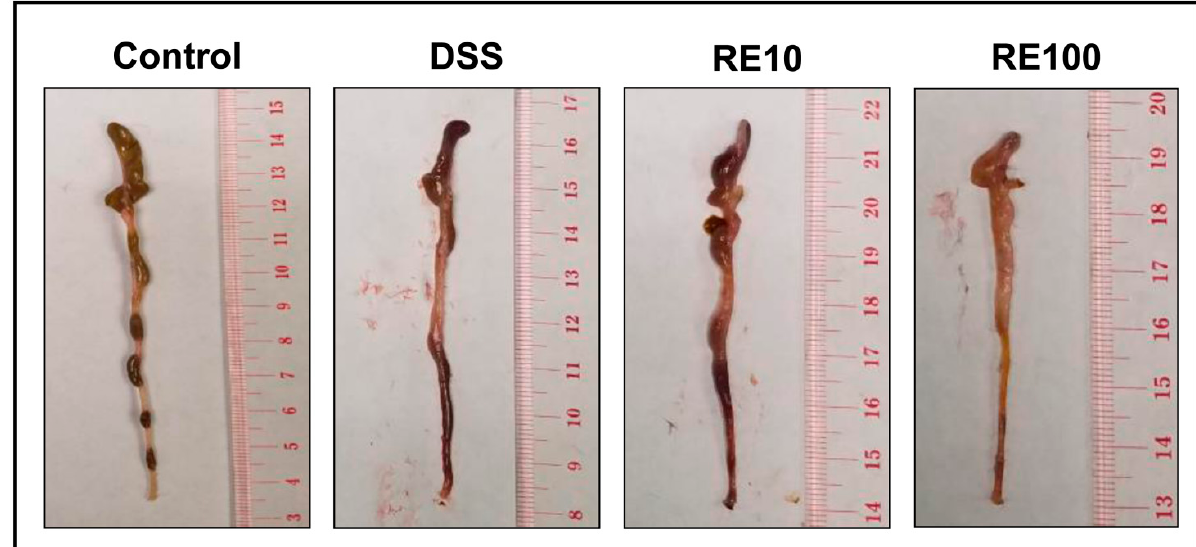
Figure 5. Representative images of mouse colons from each group ( n = 7 mice per group): Control, DSS, RE10, and RE100. Colons were excised from the cecum (top) to the distal colon (bottom) and washed in ice-cold phosphate buffered saline (PBS). Cleaned colons were then measured, weighed, and stored in ice-cold PBS at − 80 °C. DSS causes shortening and bleeding in the intestine along with increased diarrhea to the mouse. Visually, the colons from the DSS and RE10 mice contained higher amounts of blood compared to the control, but this bleeding appeared to be suppressed in the RE100 mice, indicating lower disease activity from DSS administration. Table 2. Disease activity index (DAI) scoring for DSS colitis mice treated with RE. Scoring is based on parameters defined in Section 2.7 (* p < 0.05 compared to DSS).